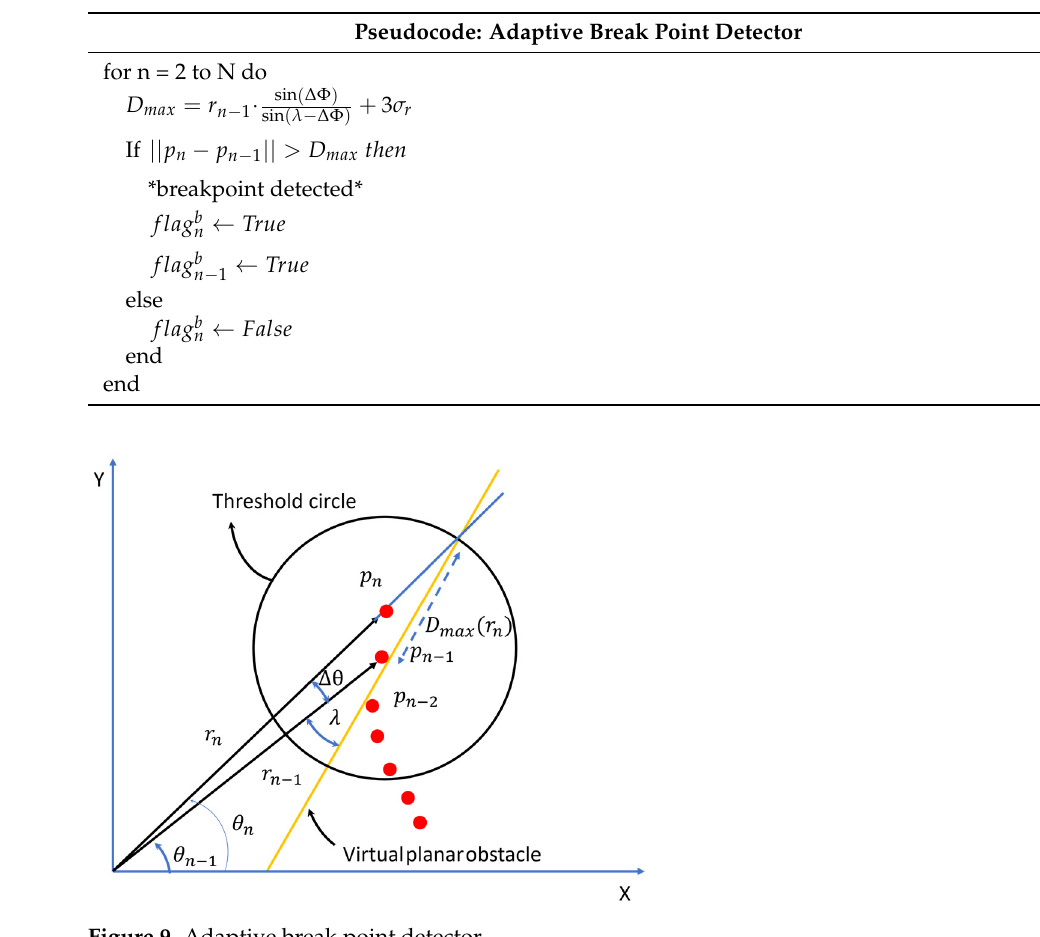
Table 1. Adaptive break point detector.